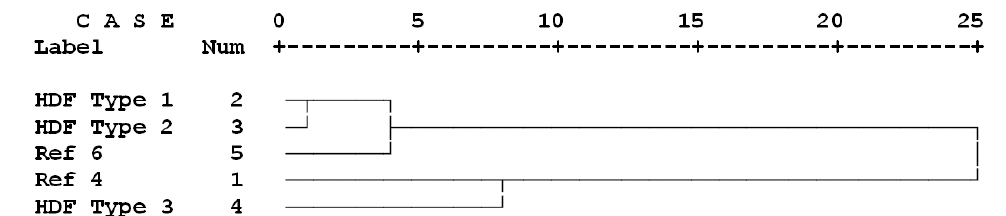
Figure 8. Cluster analysis based on all physical and mechanical properties as well formaldehyde emission between the six different HDF panels produced. REF 4: 4% UF resin; HDF Type 1: 4% UF resin and 4% ALS; HDF Type 2: 4% UF resin and 6% ALS; HDF Type 3: 4% UF resin and 8% ALS; and REF 6: 6% UF resin.